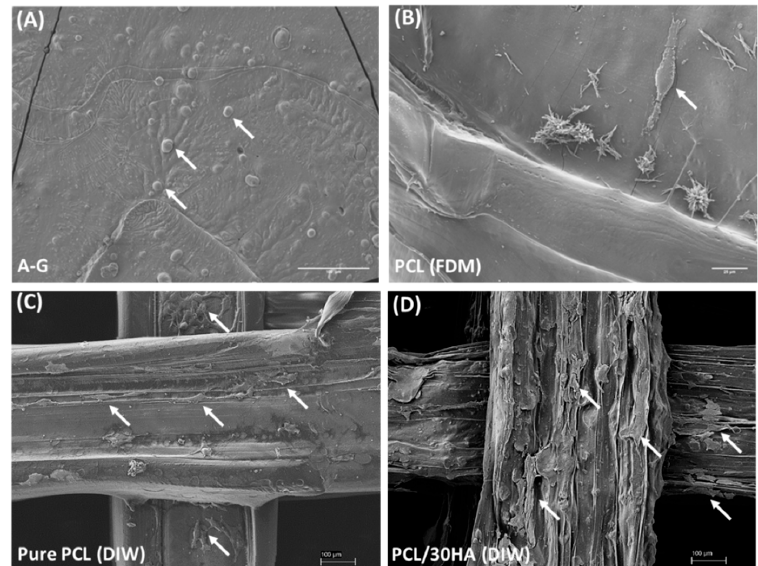
Figure 7. SEM images showing the morphology of chondrocytes and HOB cells in the bi-phasic scaffold. ( A ) Chondrocytes on the surface of bioprinted A–G bioink (scale bar 100 μ m). ( B ) Chondrocytes seeded on PCL scaffold imaged at day 7 (scale bar 20 μ m). HOB cells attached on the top two layers of DIW printed pure PCL ( C ) and PCL/30HA ( D ) porous scaffolds after 24 h of culture are shown (scale bar 100 μ m). Cells are pointed out with arrows.